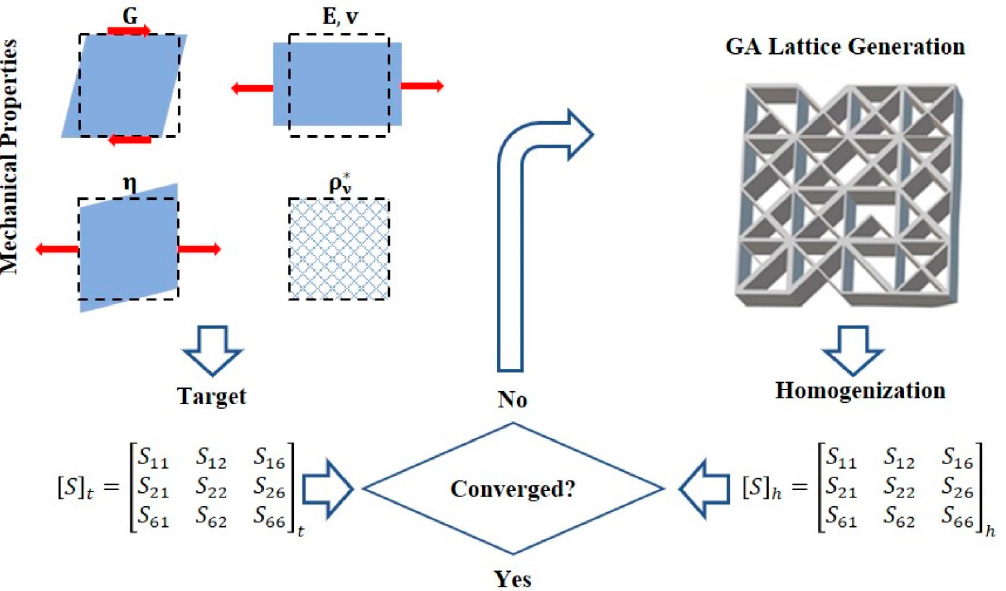
Figure 4. Inverse homogenization iterative process: The combined genetic algorithm and homoge- nization based scheme identifies inner material architectures that can optimally meet different target macroscale material properties ( G , E , ν , η ) , as encapsulated in the compliance homogenized tensor S h , up to convergence with the target compliance tensor S t (Adapted with permission from Dos Reis et al., 2022) [46].